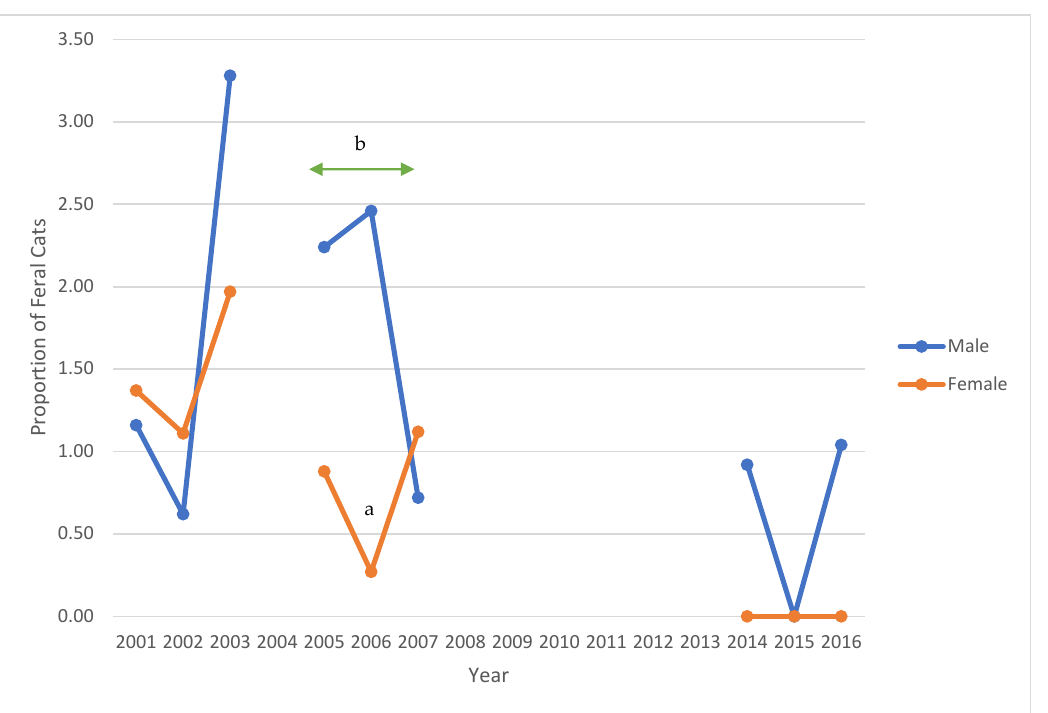
Figure 2. Prevalence of feline leukemia virus-positive (FeLV+) and feline immunodeficiency virus-positive (FIV+) feral cats presented to the PHS Spay/Neuter Clinic, 2001–2003, 2005–2007, and 2014–2016. Note: a— p = 0.01 compared with previous two periods.